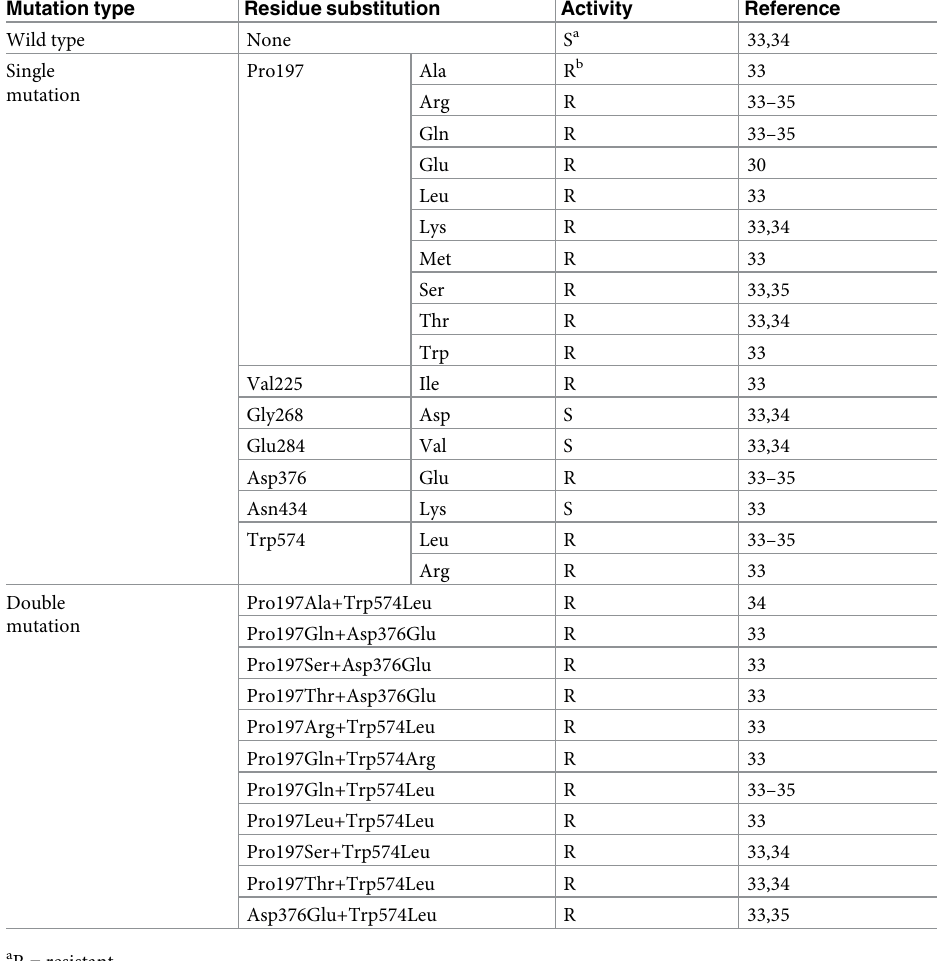
Table 1. AHAS mutations in field Kochia scoparia populations along with their experimentally determined resis- tance to tribenuron methyl and thifensulfuron